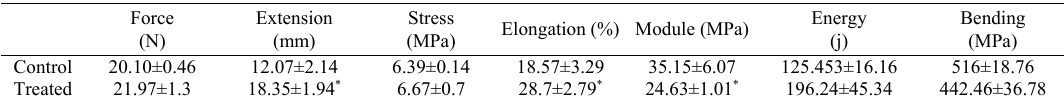
Table2: The values are presented as mean ± standard deviation